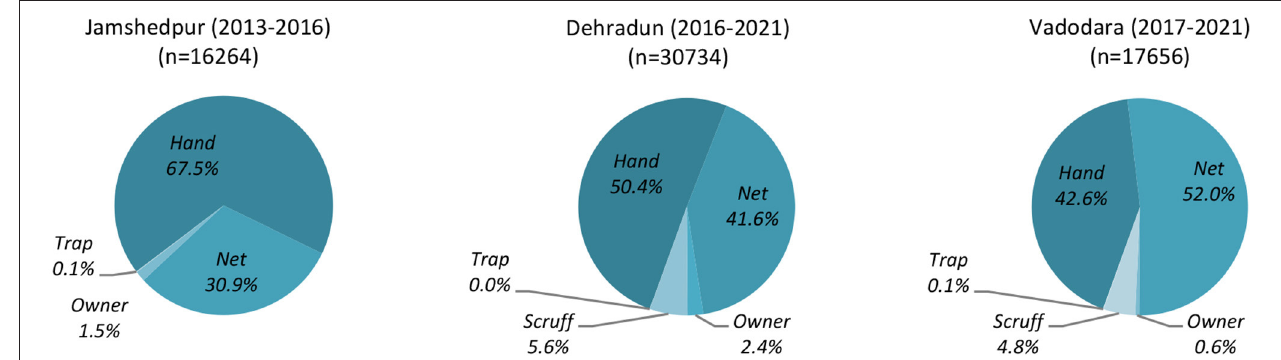
FIGURE 1 | Clinic catch method in the Indian cities Jamshedpur, Dehradun, and Vadodara over the durations of data collection periods.